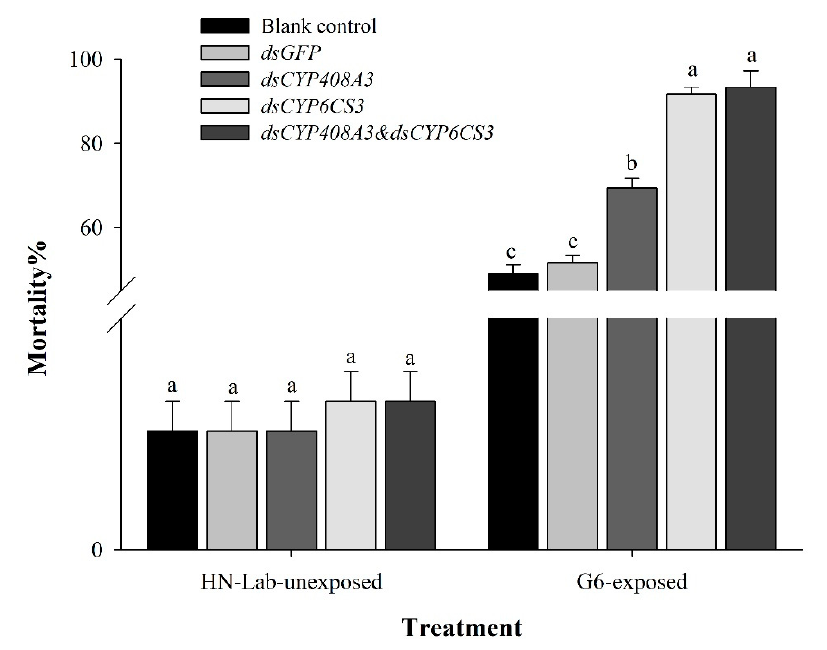
Figure 6. Mortality at 72 h of the dsRNA-injected fifth instar nymphs after being unexposed to the chlorpyrifos in the HN-Lab and exposed to the chlorpyrifos in the XY17-G6 population. Significant differences are indicated by different letters, for example, a, b, and c ( p < 0.05, with a Student’s t - test).